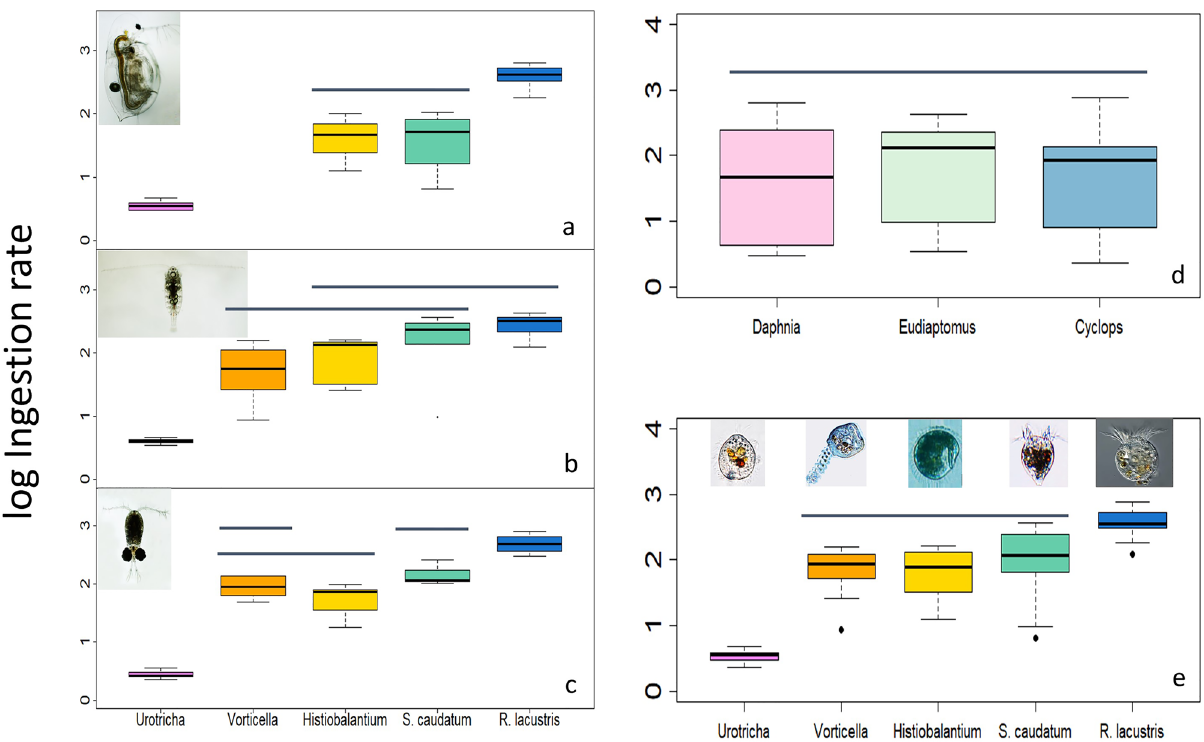
Figure 1. Box plots of log 10 –transformed ingestion rates (logIR, ng C ind −1 d −1 ) of the three microcrustacean predators. ( a – c ) LogIR of Daphnia ( a ), Eudiaptomus ( b ), and Cyclops ( c ) on the five ciliate species; ( d ) combined logIR of the three microcrustacean species; ( e ) combined logIR of all predators on each ciliate species. The boundary of the box closest to zero indicates the 25th percentile, the solid line within the box marks the median, and the boundary of the box farthest from zero indicates the 75th percentile. Error bars above and below the box indicate the 90th and 10th percentiles. The horizontal bars indicate logIR that were not significantly